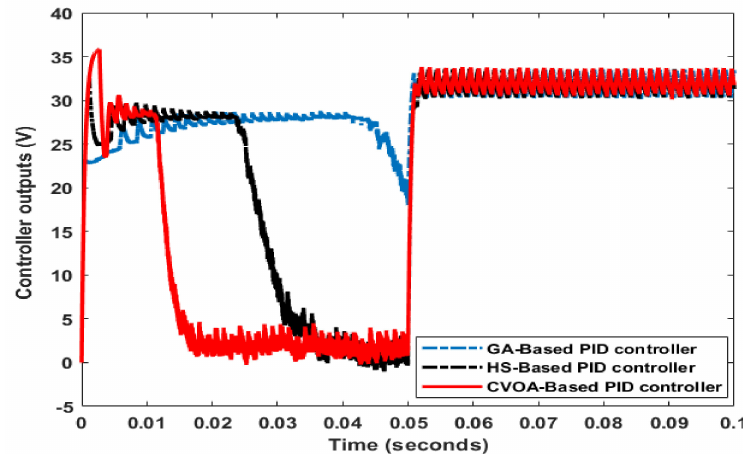
Figure 8. The controller outputs at speed regulation with sudden load test.